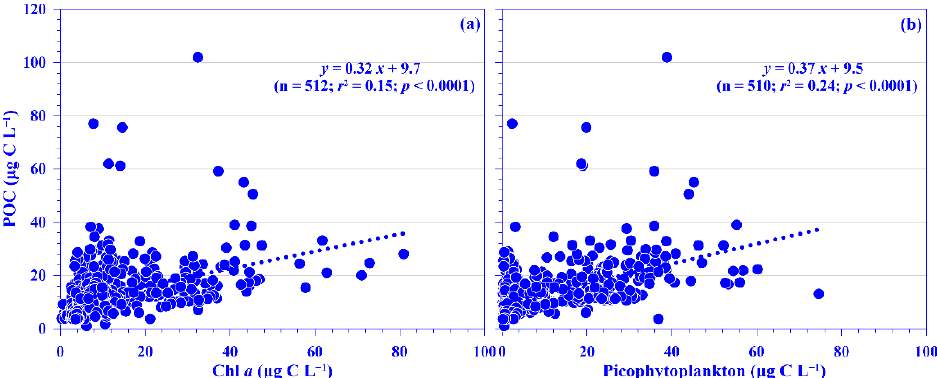
Figure 6. Relationships between concentration of particulate organic carbon (POC) and ( a ) chlorophyll a (Chl a ) and ( b ) picophytoplankton for all pooled data. The r 2 and p values of linear relationships are shown.